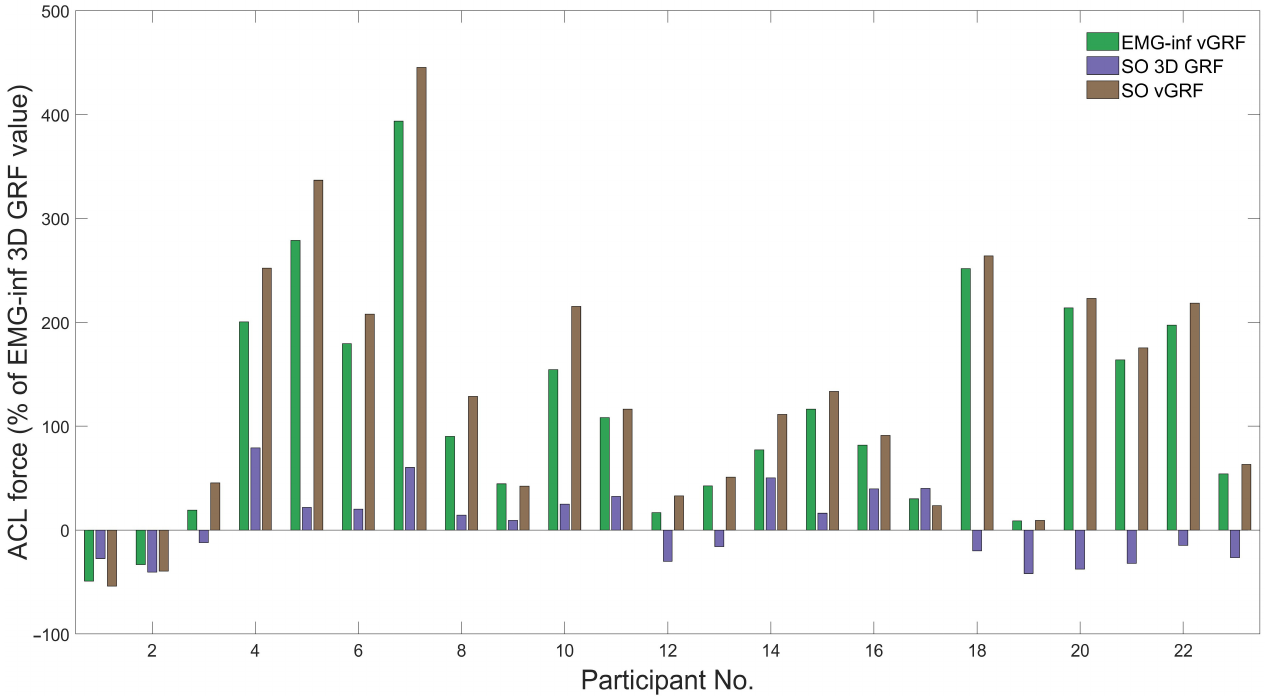
Optimisation + vertical GRF (brown line). Grey-shaded regions display statistical differences using a paired t-test applied through Statistical Parametric Mapping. vGRF, vertical ground reaction force; EMG-inf, EMG-informed; SO, static optimisation.